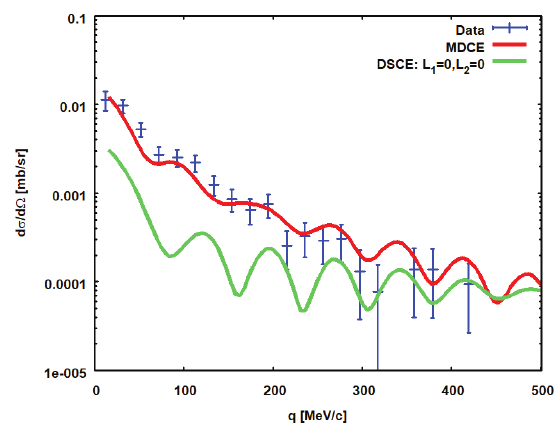
Figure 3. Angular distribution of the DCE reaction 18 O + 40 Ca Ne + 40 Ar at T lab = 270 MeV. The one-step MDCE and the two- step DSCE cross sections are shown separately in comparison to the data of Ref.